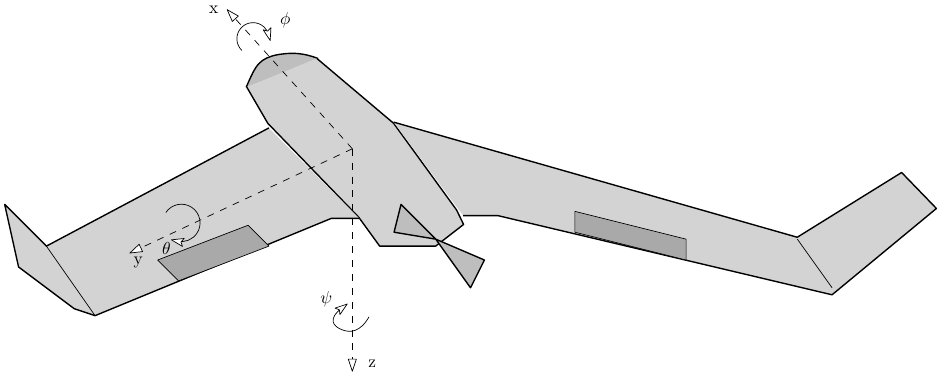
Figure 1. UAV schematic (elevons on wings shown in darker grey